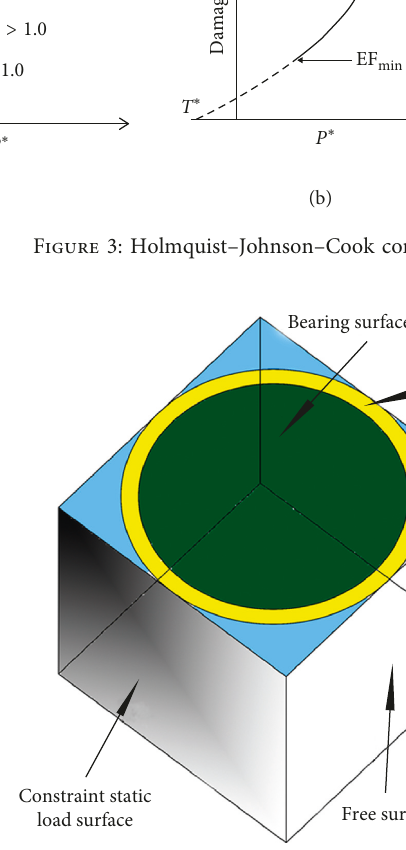
Figure 4: Conventions of each surface of coal-rock model.